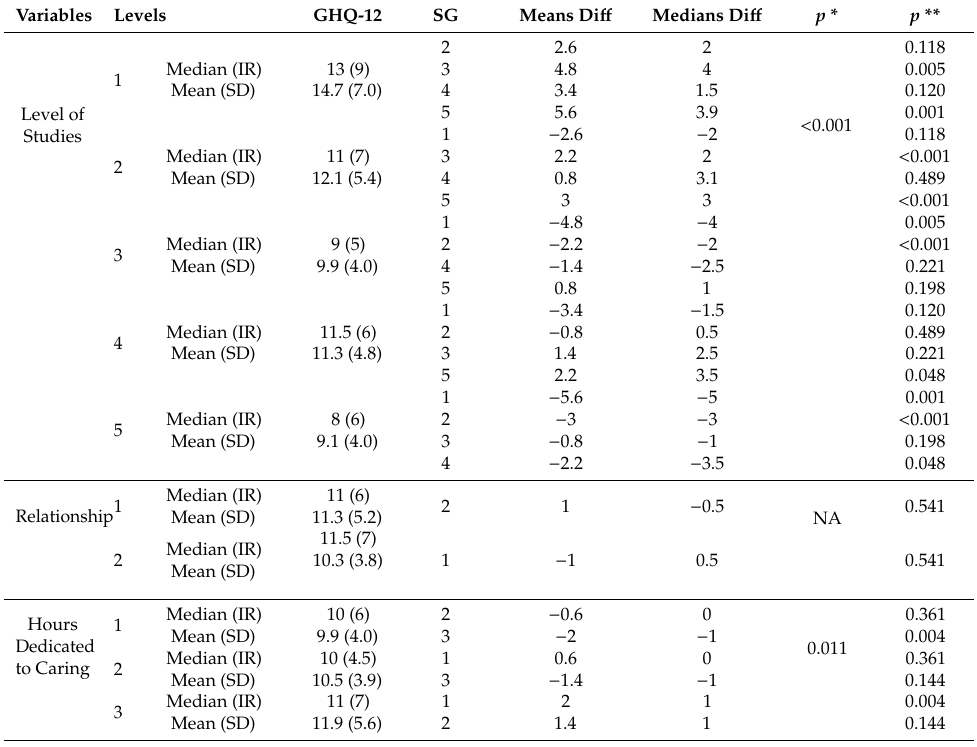
Table 2. Comparison of GHQ-12 according to the level of studies, relationship with the care recipient and hours spent in